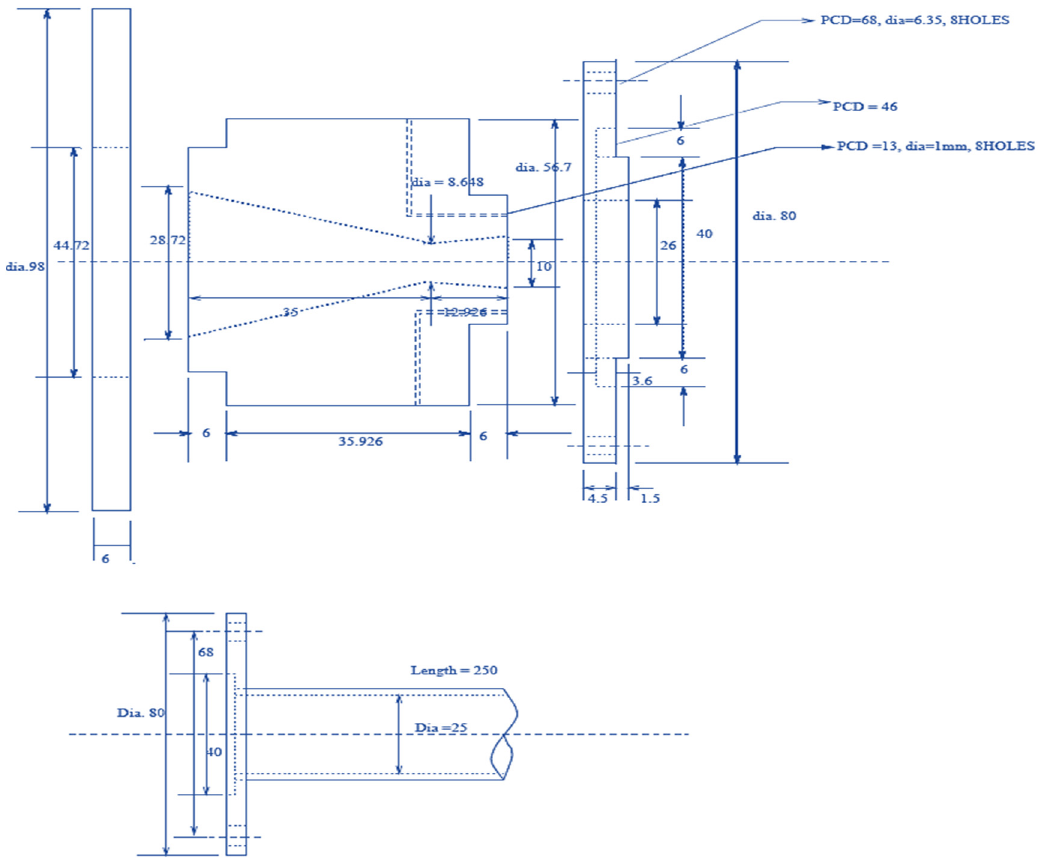
Figure 6. Flow expansion, nozzle, and enlarged duct design for Mach number 1.87.